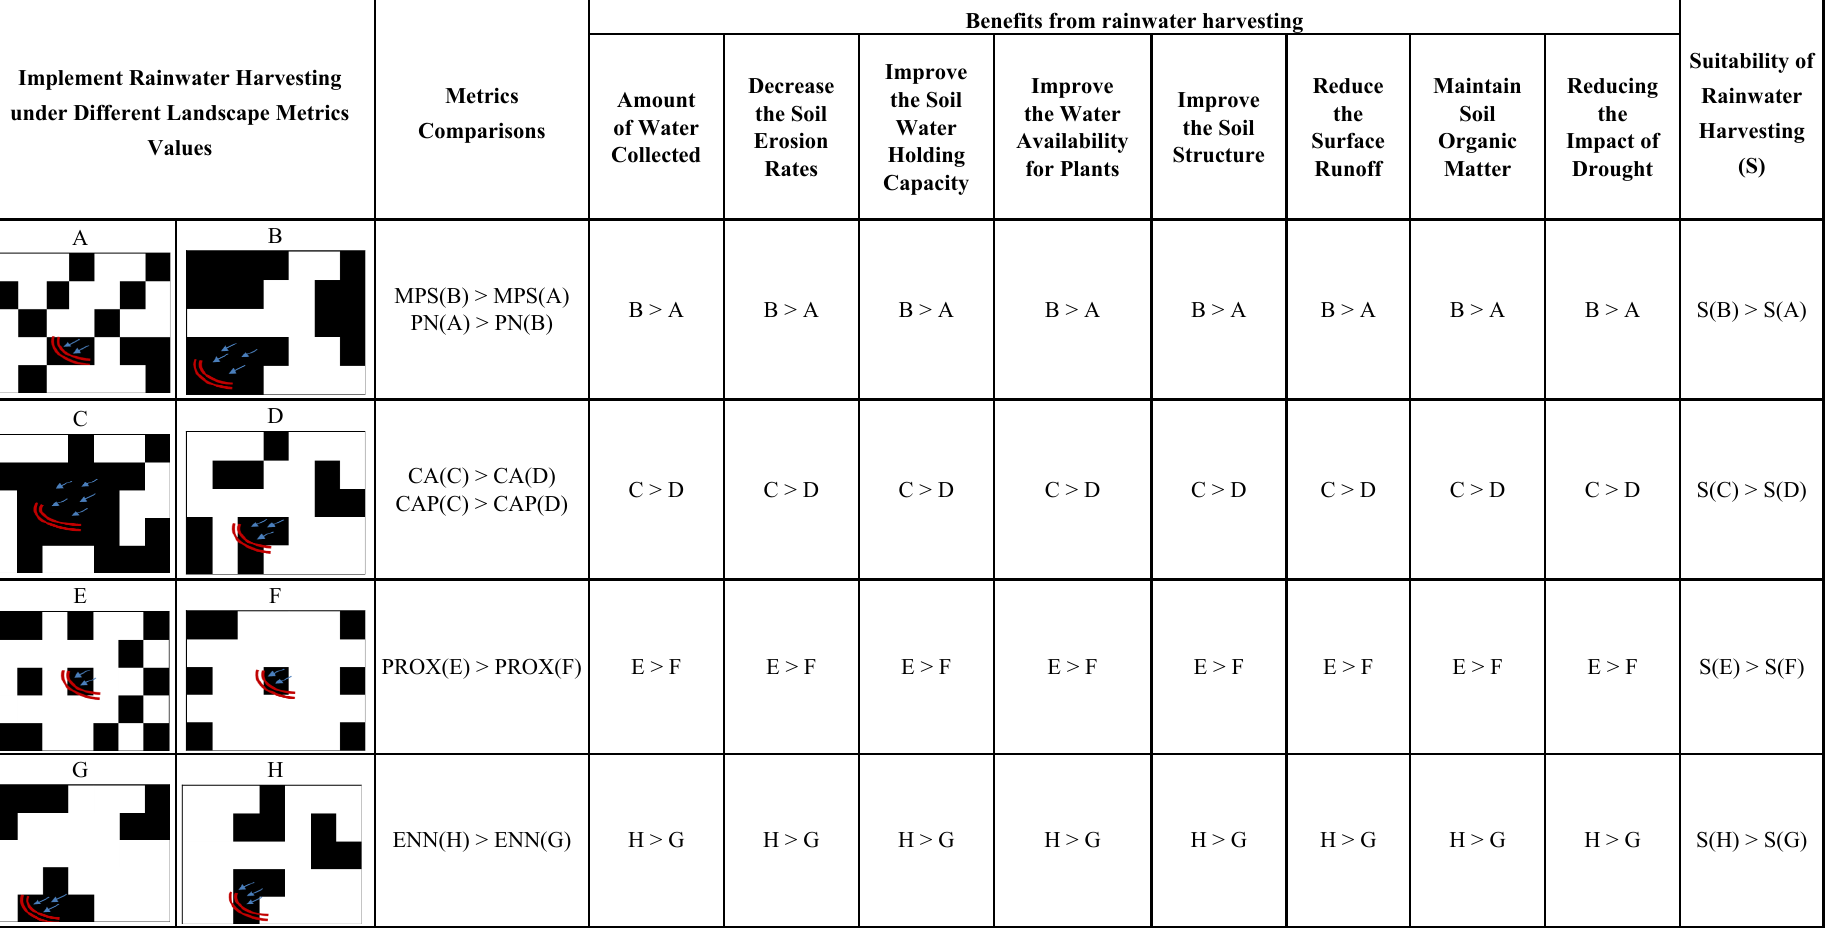
Table 2. Rainwater harvesting benefits according to various landscape metrics